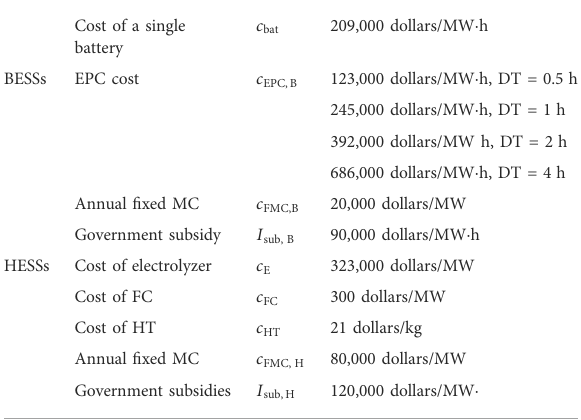
TABLE 5 Main parameters of BESSs and